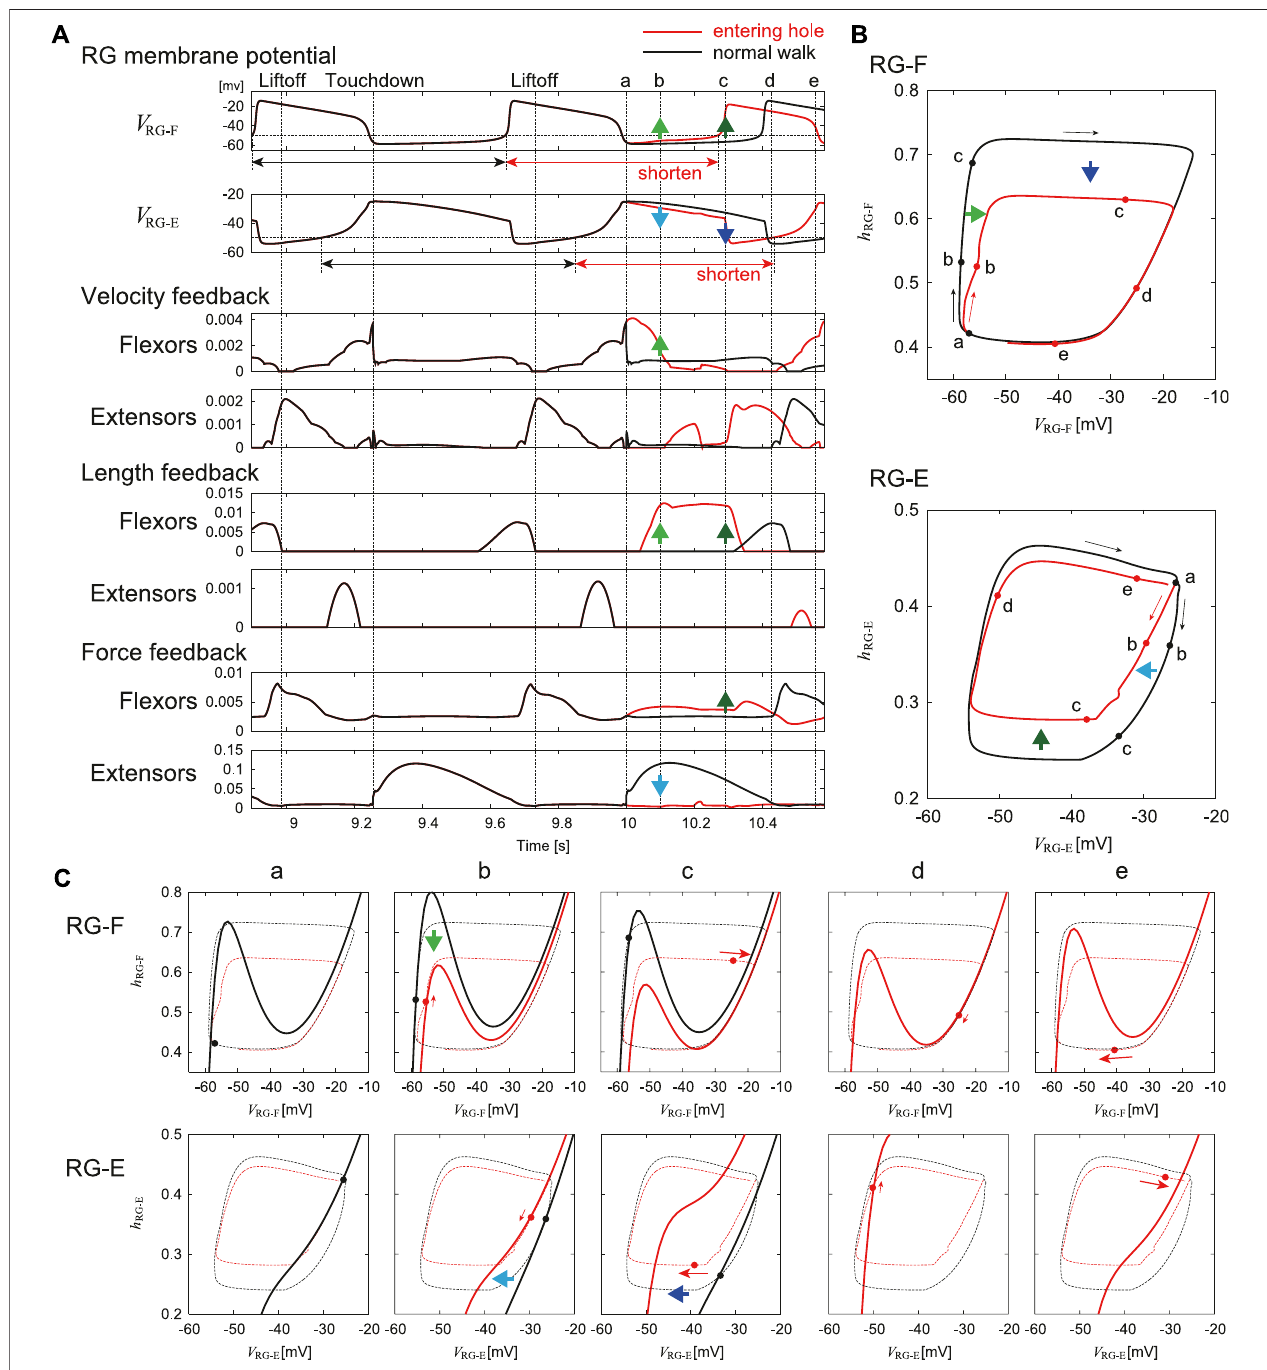
FIGURE7| ComparisonoftheresponseofRGneuronstoafootenteringaholewithsteadyoscillationduringnormalwalking. (A) Timepro fi lesofmembranepotentialsand afferentfeedbackfrom fl exorandextensormuscles. “ a ” indicatesthetimeatwhichthefootentersthehole(touchdowninnormalwalking). “ b ”–“ e ” indicatethelapsedtimesof0.1, 0.29, 0.43, and 0.56 s, respectively, after “ a ” . (B) Trajectories of ( V RG - F , h RG - F ) and ( V RG - E , h RG - E ) in phase planes. (C) Changes of nullclines ^ N V RG - F and N